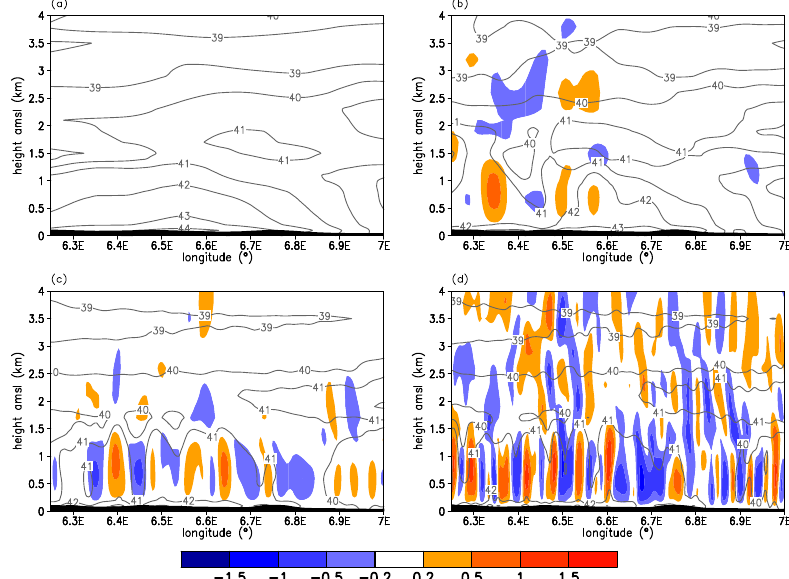
Figure 6. Vertical cross sections of vertical wind speed (shading, in ms − 1 ) and equivalent potential temperature (gray contours in ◦ C) at the latitude of the KITcube location on 25 April 2013 at 12:00UTC for (a) 2.8km, (b) 1km with 1-D turbulence, (c) 500m, and (d) 250m grid